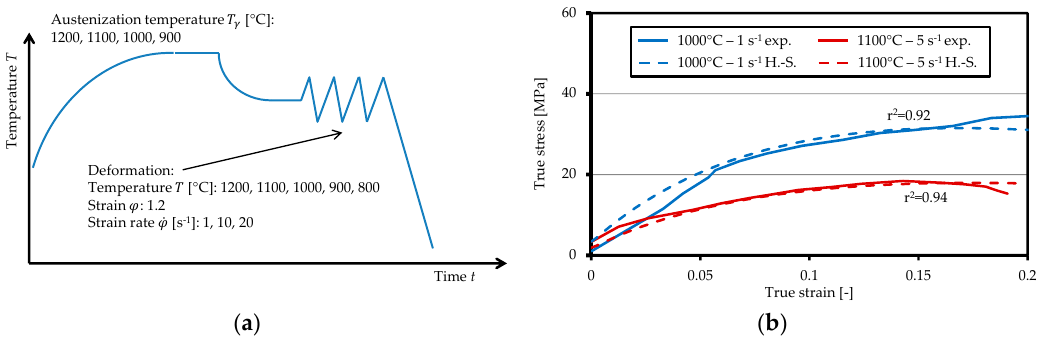
Figure 2. Schematic representation of the experimental procedure for the determination of flow curves for the steel matrix ( a ); Exemplary results of experimental cylindrical compression test and calculated true stress (H.-S.) for the pure iron oxide wuestite (based on [13]) ( b ).